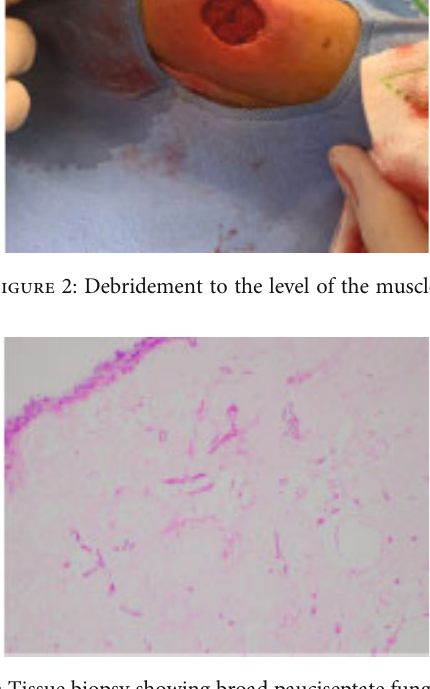
Figure 3: Tissue biopsy showing broad pauciseptate fungal hyphae with wide-angle branching in necrotic adipose tissue, consistent with zygomycosis (H&E, ×